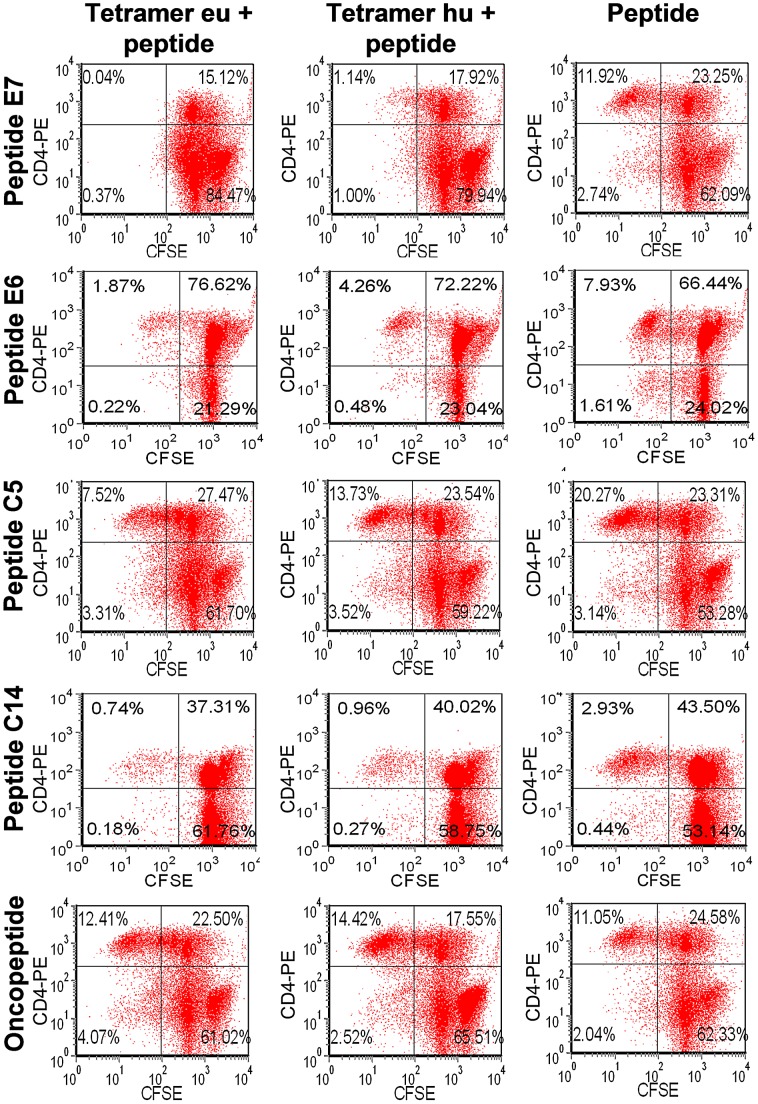
Proliferation of TCR tetramer-treated and -untreated PBMCs.After 9 days of cultivation, CFSE-labeled PBMCs were stained with PE-labeled CD4 MAbs and analyzed by flow cytometry in order to determine their proliferation activities. Determination of the divided cells was based on the low-CFSE fraction. The results show that peptides E7, E6, C5, and C14 and oncopeptide promoted the proliferation of CD4+ T cells (the third line). When loaded with the eu- or hu-tetramer, the percentage of low-CFSE CD4+ T cells treated with peptides E7, E6, C5 or C14 decreased (the first and the second row) but not cells treated with oncopeptide.